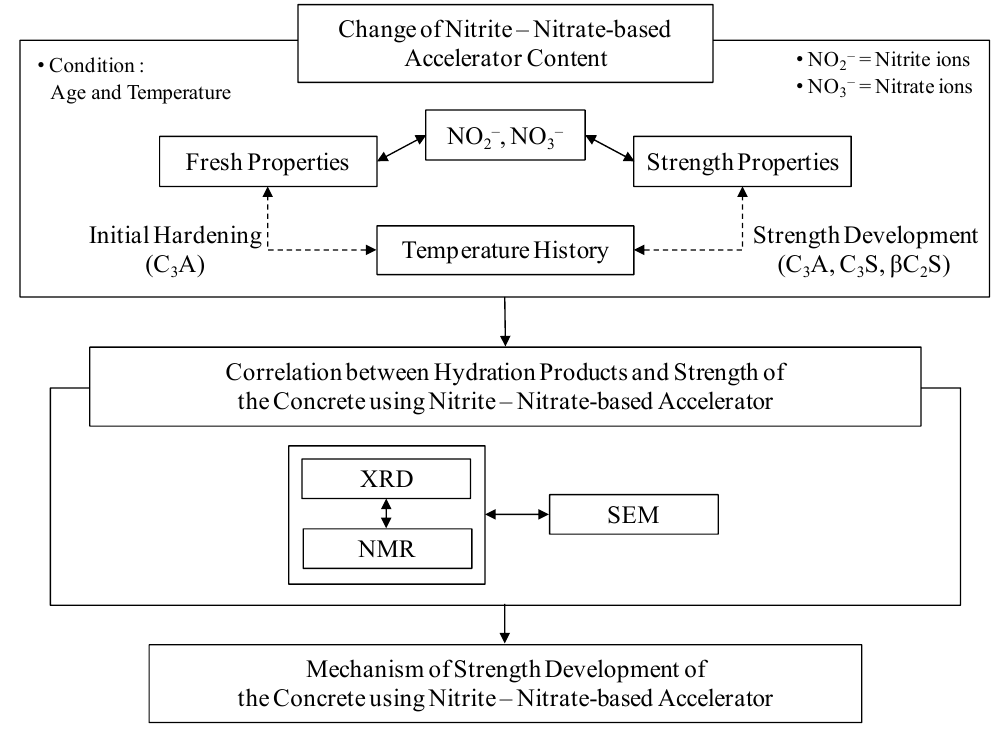
Figure 1. Study flow chart.